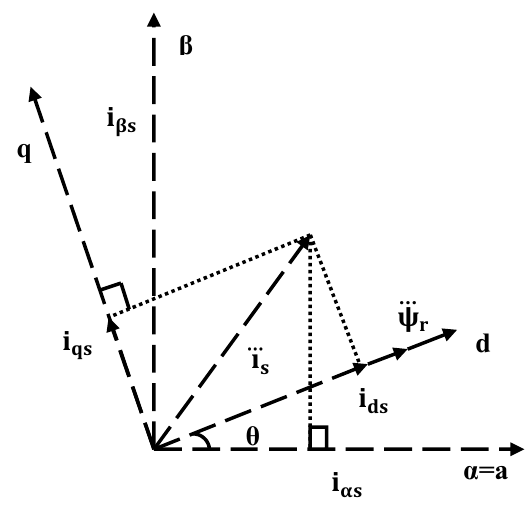
Figure 1. Indirect vector control principle.